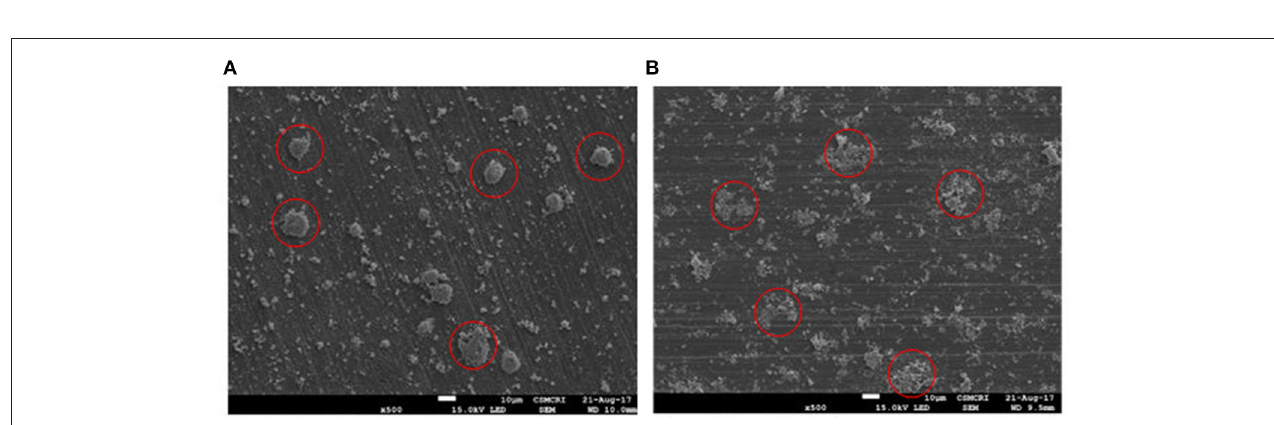
FIGURE 9 | SEM image of materials. (A) SEM image of HRO. (B) SEM image of Ru-HRO-2 (Recovered material from Table 1 , entry 13).